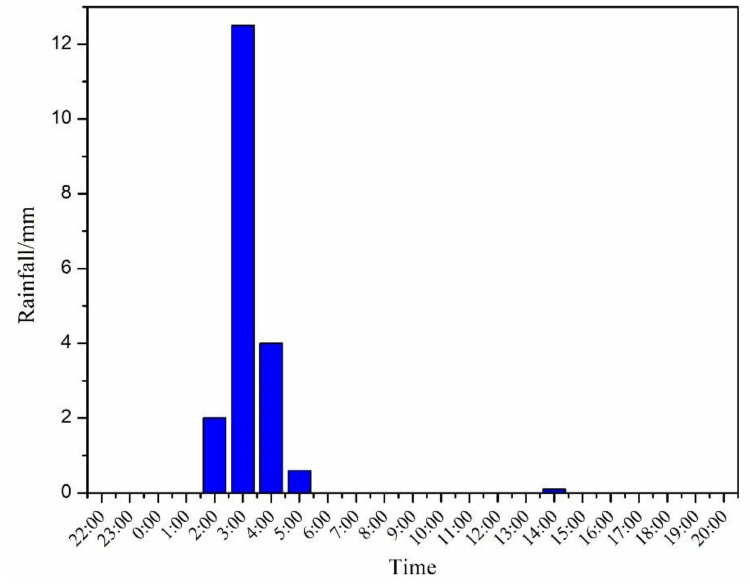
Figure 3. Rainfall